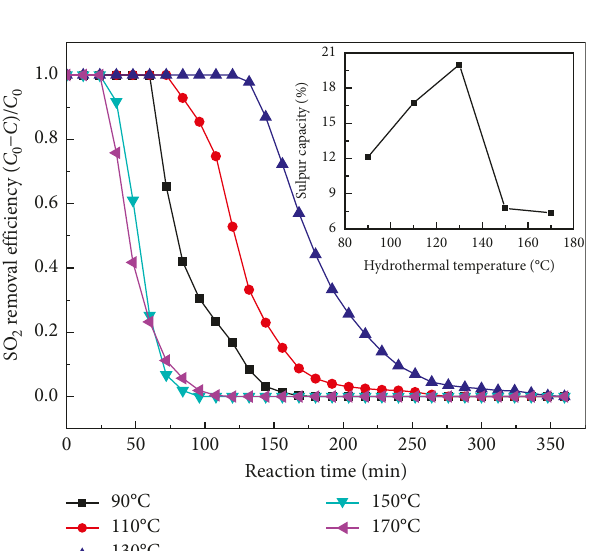
Figure 5: Effect of zinc ferrite/activated carbon at different hydrothermal reaction temperatures on desulfurization reactivity.